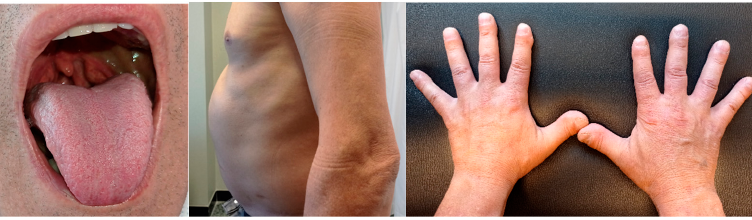
Figure 1. ( Left ): Orange tonsils. ( Middle ): Massive hepatosplenomegaly. ( Right ): Clubbing.